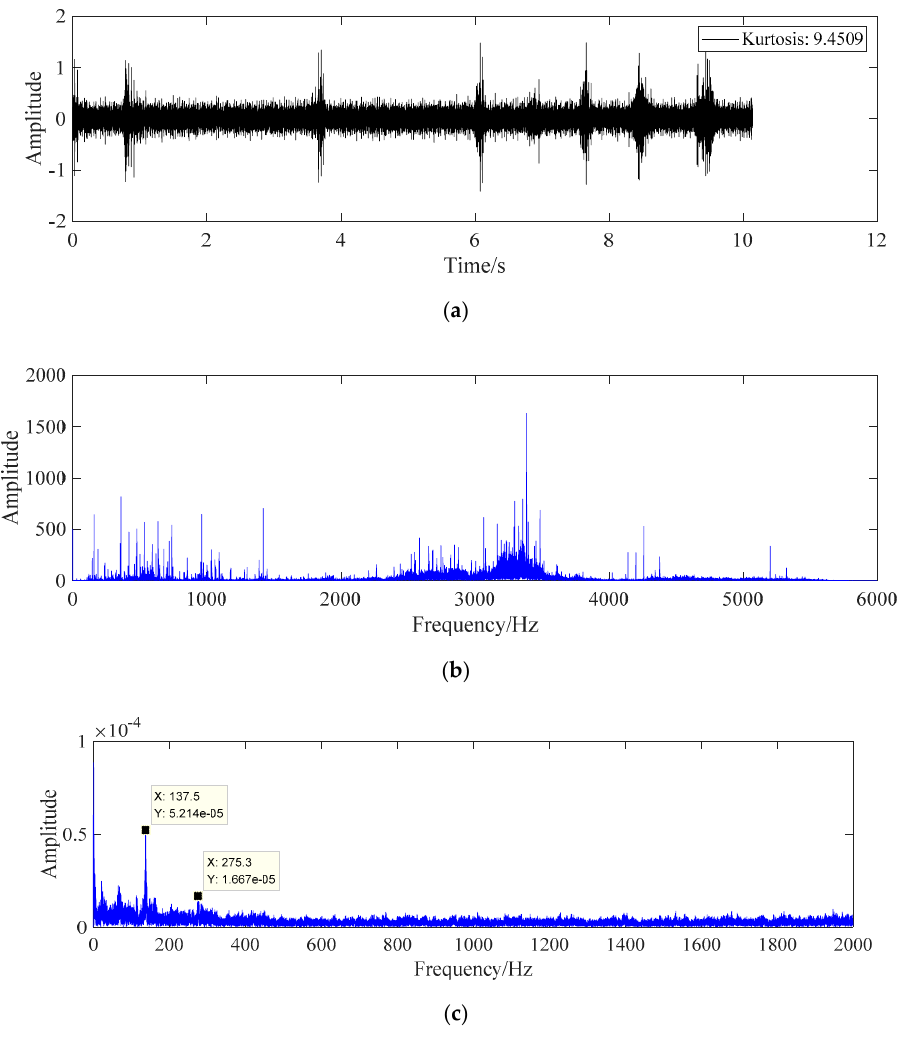
Figure 11. The fault diagnosis diagram of fault data C. ( a ) Time domain diagram of fault data C. ( b ) Frequency domain diagram of fault data C. ( c ) Fault data C whitening energy operator frequency domain graph